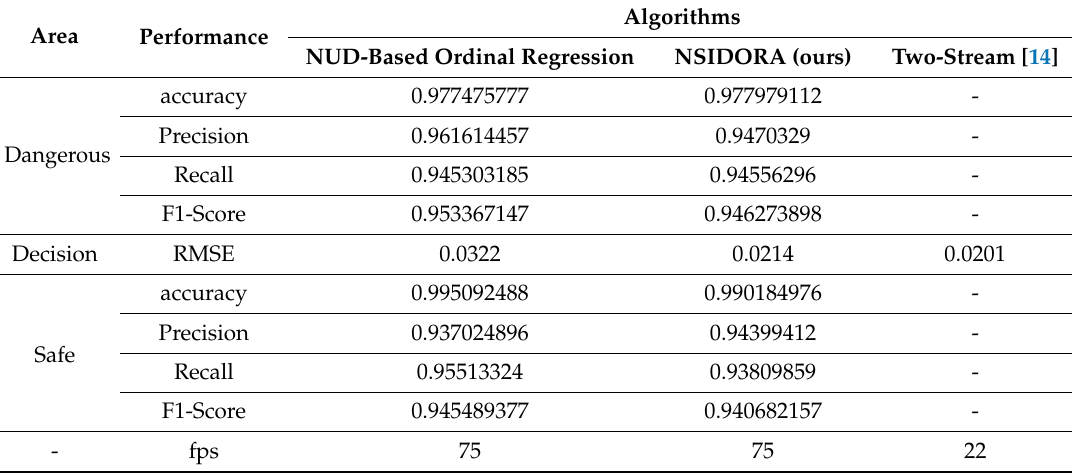
Table 1. Performance comparison of